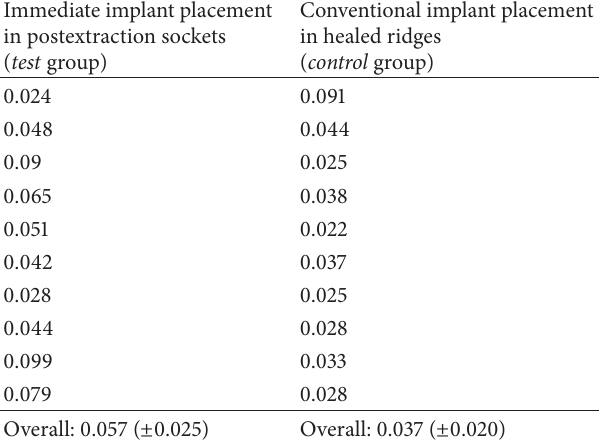
Table 1: Soft tissue contraction around single implants inserted to replace failing/nonrestorable ( test group: immediate implant placement in postextraction socket) and missing ( control group: conventionalimplantplacementinhealedridge)lateralincisors.The assessment of soft tissue contraction was performed via calculation of the Euclidean surface distances between the 3D models, after the superimposition of S2 on S1, in mm, over a 2-year